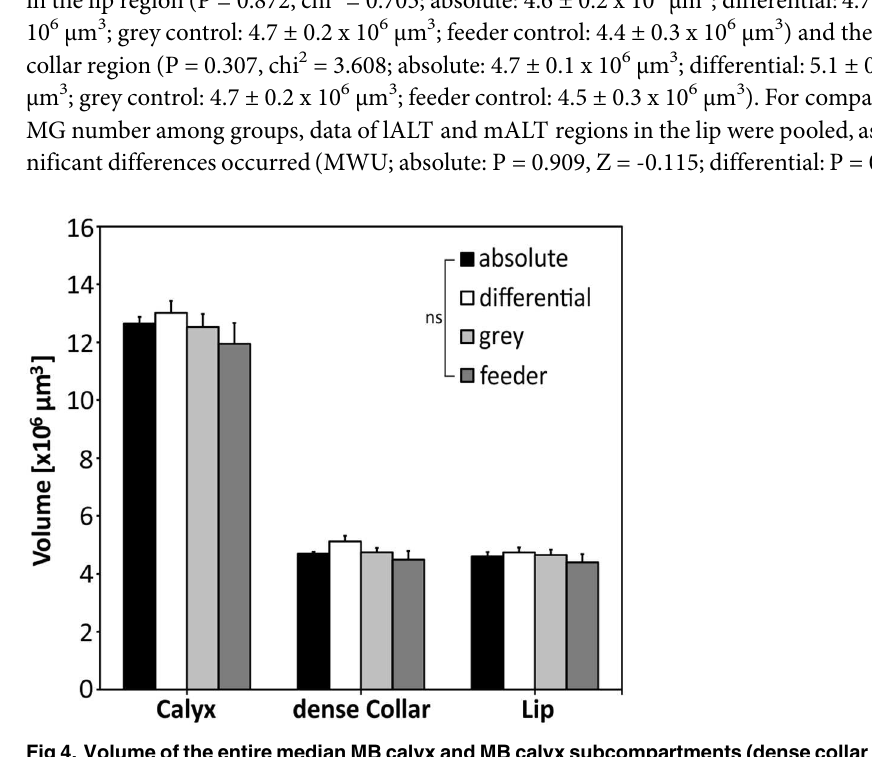
Fig 4. Volume of the entire median MB calyx and MB calyx subcompartments (dense collar and lip). No differences were found among experimental groups for the volumes of the entire calyx, dense collar and lip regions. ns: not significant; absolute: N = 13; differential: N = 14; grey: N = 10; feeder: N =